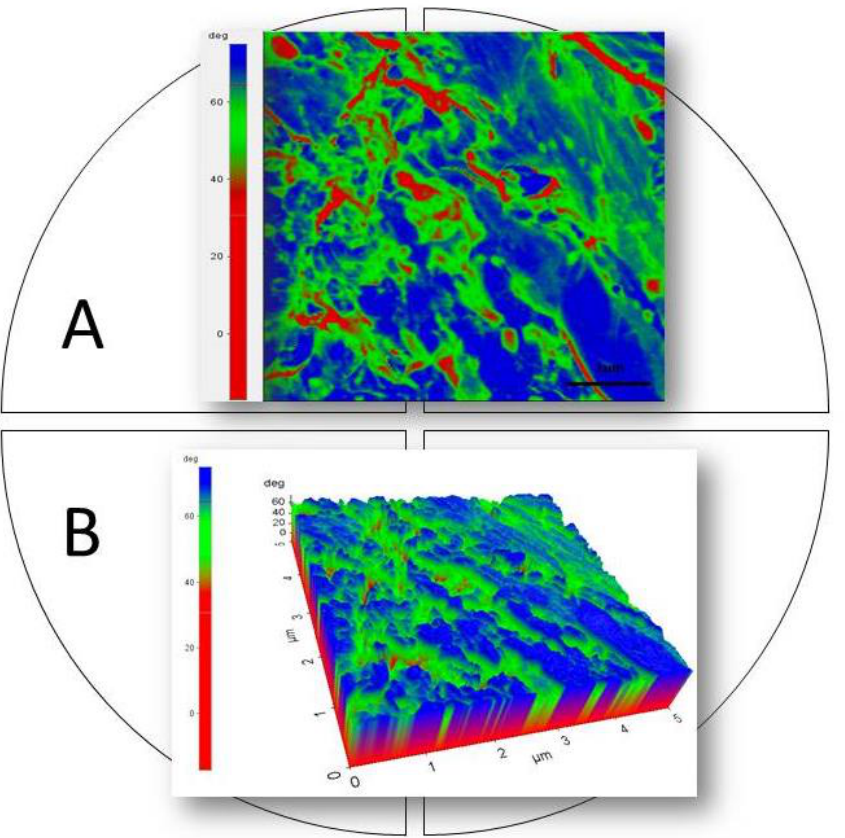
Figure 8. ( A ) Phase contrast images of the sample in 2d. ( B ) Phase contrast images of the sample in 3d.